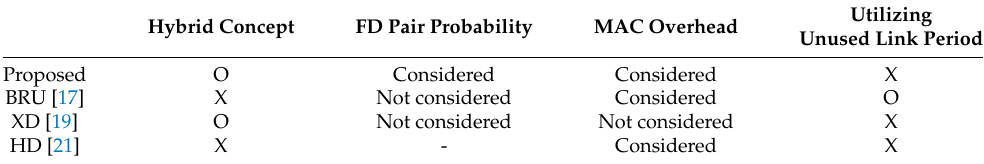
Table 3. Comparison of FD MAC protocols. XD,